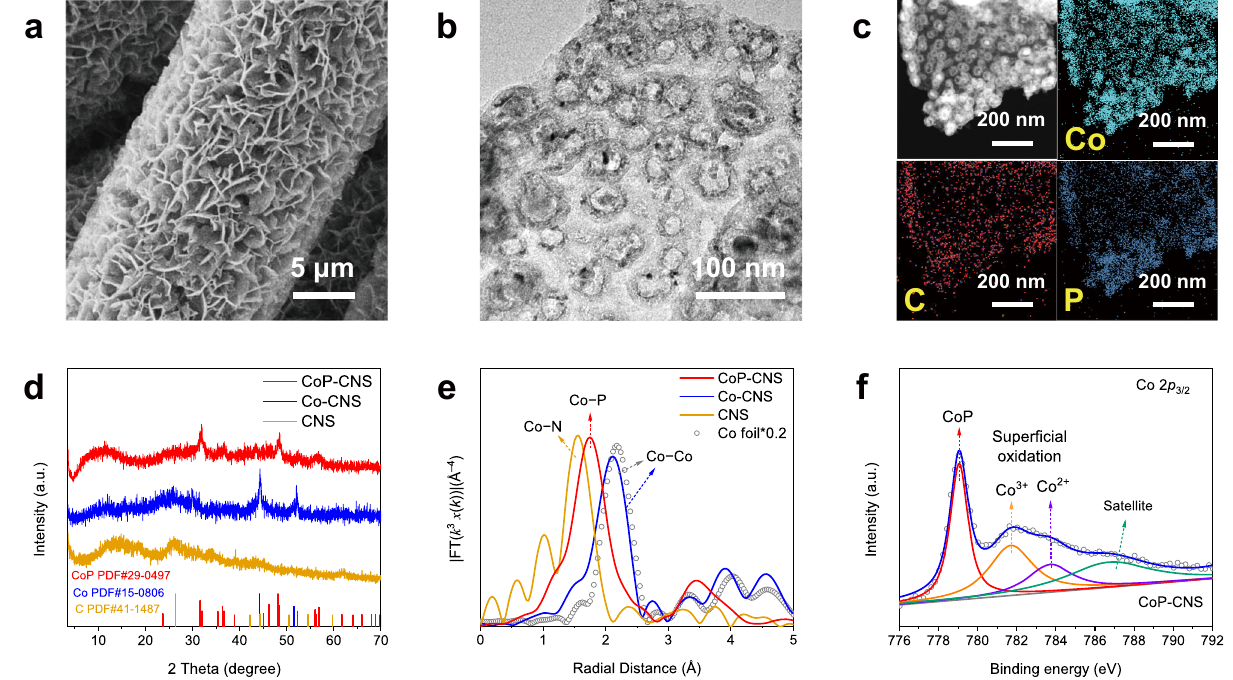
Fig. 1 | Synthesis and characterization of CoP-CNS and corresponding control samples. a SEM, b STEM, and c corresponding EDX mapping images of CoP-CNS. d XRD pattern and e Fourier transform k 3 -weighted χ (k)-function of the EXAFS